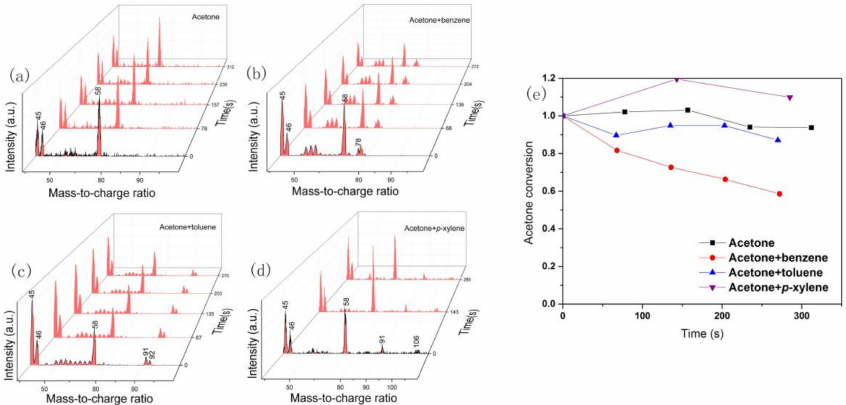
Figure 8. In situ mass spectrometry result of the outlet gas at ED = 1600 J/L: Acetone ( a ), acetone and benzene ( b ), acetone toluene ( c ) and acetone and p -xylene degradation ( d ) and acetone conversion ( e